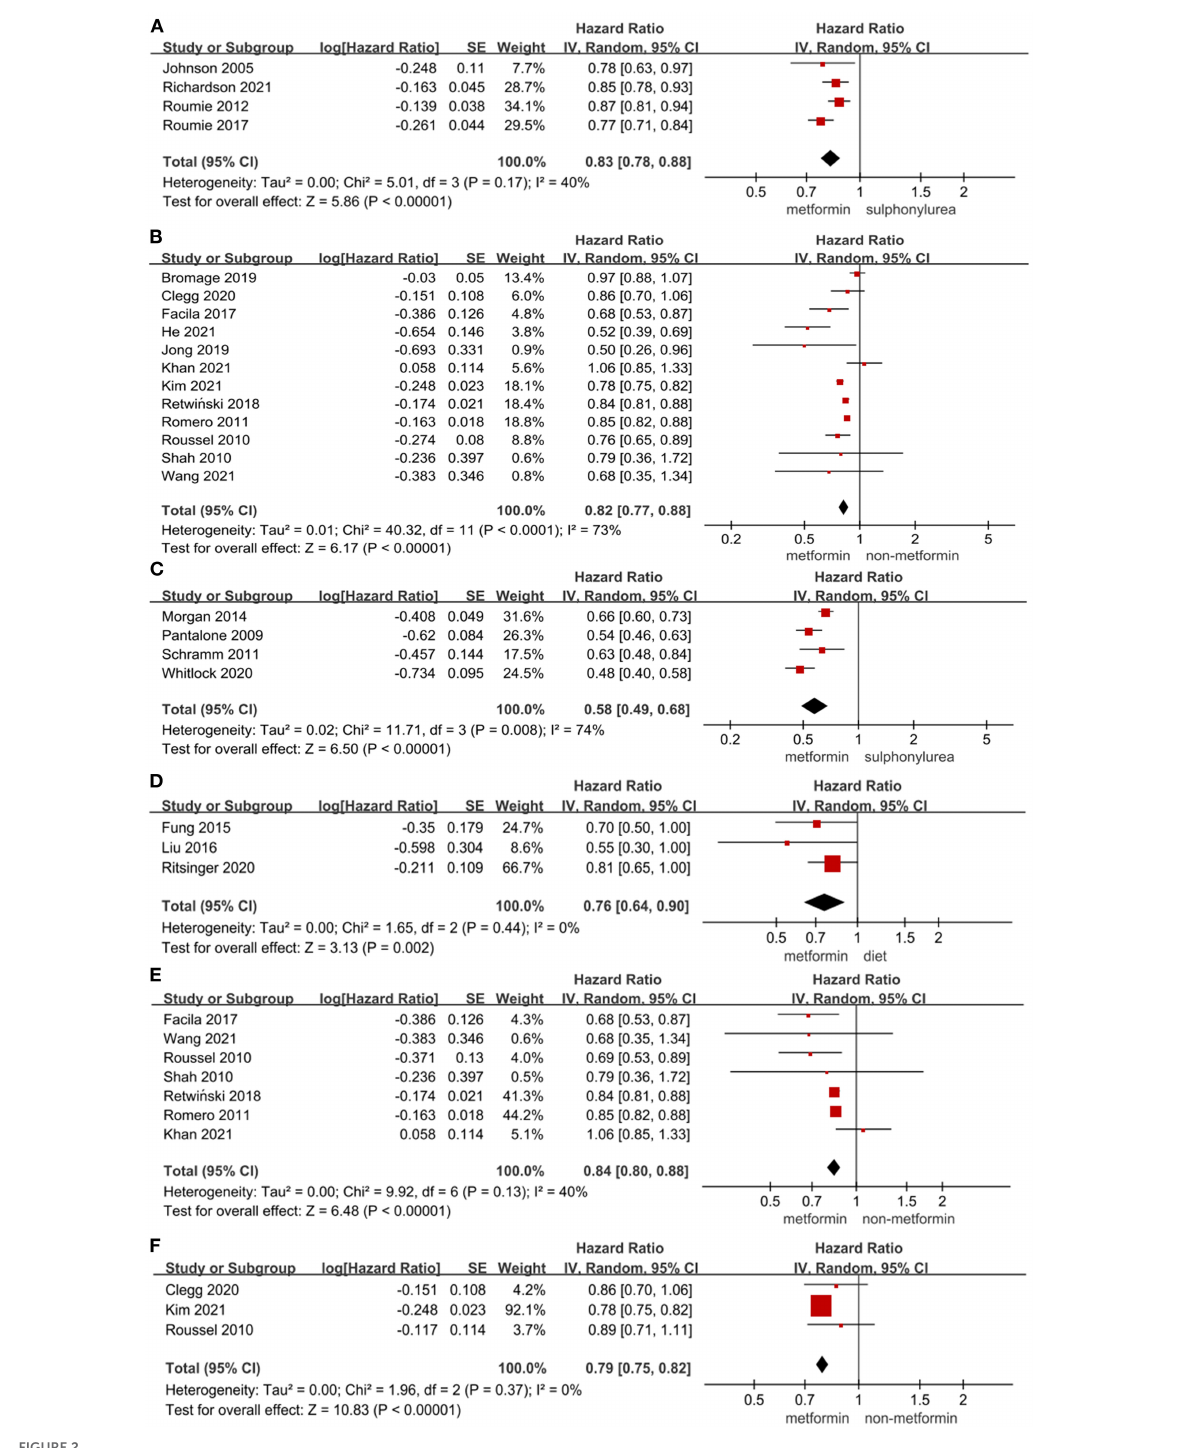
FIGURE2 (A) Forest plot of hazard ratio of hospitalization among patients with metformin therapy vs. sulphonylurea therapy. (B) Forest plot of hazard ratio of all-cause mortality among patients with metformin therapy vs. non-metformin therapy. (C) Forest plot of hazard ratio of all-cause mortality among patients with metformin therapy vs. sulphonylurea therapy. (D) Forest plot of hazard ratio of all-cause mortality among patients with metformin vs. diet therapy. (E) Forest plot of hazard ratio of all-cause mortality among heart failure patients with metformin therapy vs. non-metformin therapy. (F) Forest plot of hazard ratio of all-cause mortality among patients with CKD treated with metformin therapy vs non-metformin therapy. CI, confidence interval; SE, standard error; IV, inverse of the